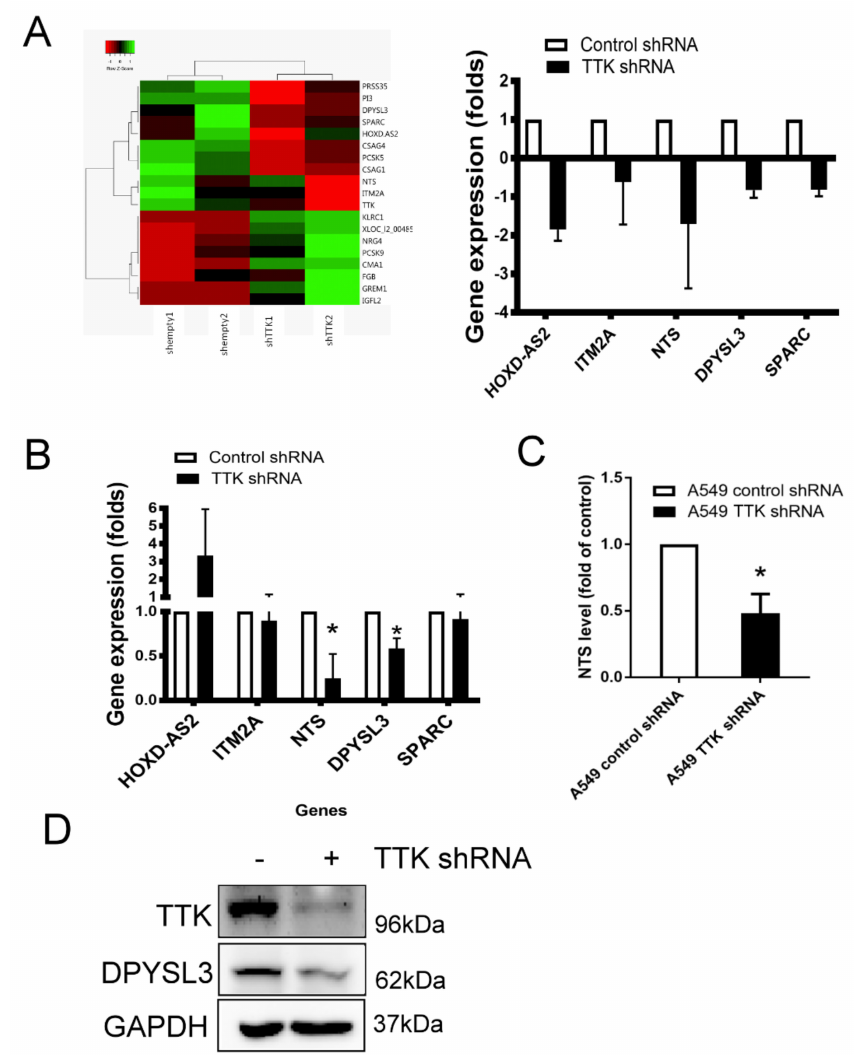
Figure 4. The gene profile of TTK-knockdown A549 cells. ( A ) The heat-map. The gene profile of TTK knockdown A549 cells was established by a microarray. ( B ) The decrease genes of TTK knockdown A549 cells. The expressions of various mRNAs were measured by qRT-PCR. Knockdown of TTK decreased neurotensin (NTS; C ) and DYPSL3 ( D ) expression protein levels. The level of NTS in the supernatants of control or TTK knockdown A549 cells was determined by ELISA after 48 h incubation. The expression of DYPSL3 was assessed by an Immunoblot. All experiments were performed independently at least three times. * Significant di ff erence when comparing with control group ( p <